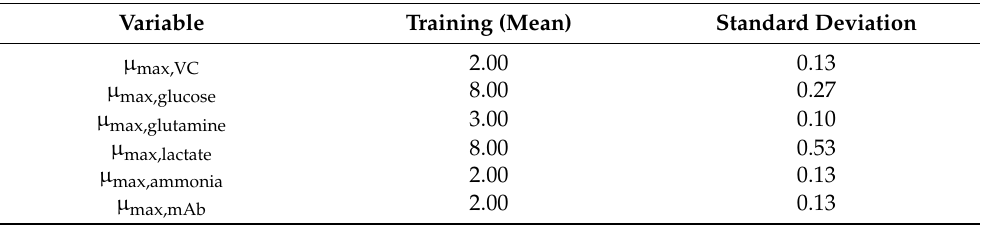
Table A3. Mean (training) and standard deviation values of the parameters used for hybrid in silico batches